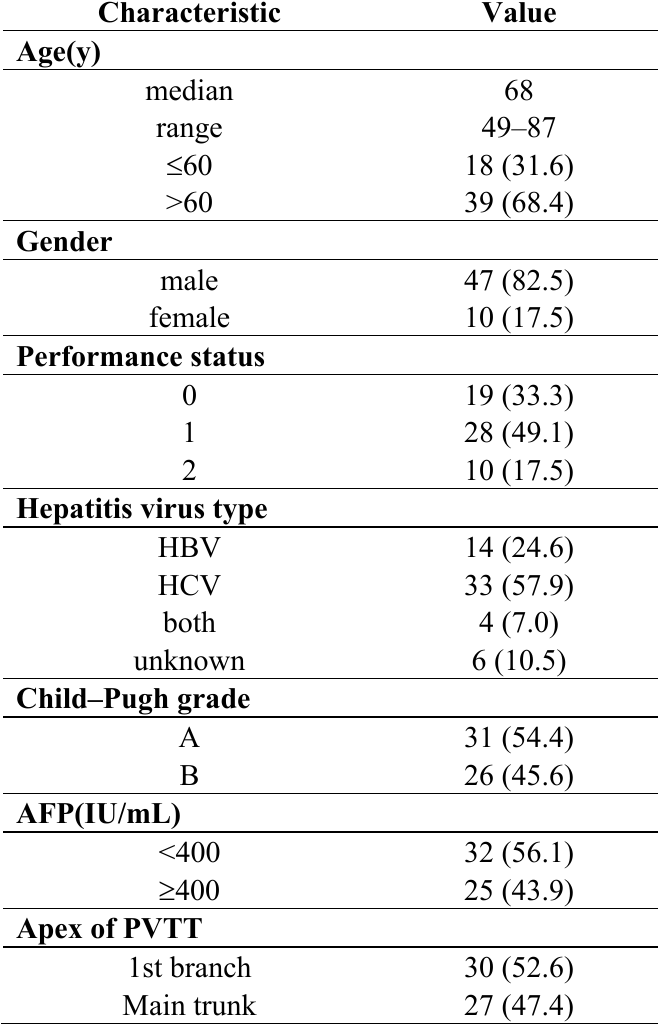
Table 2. Patient